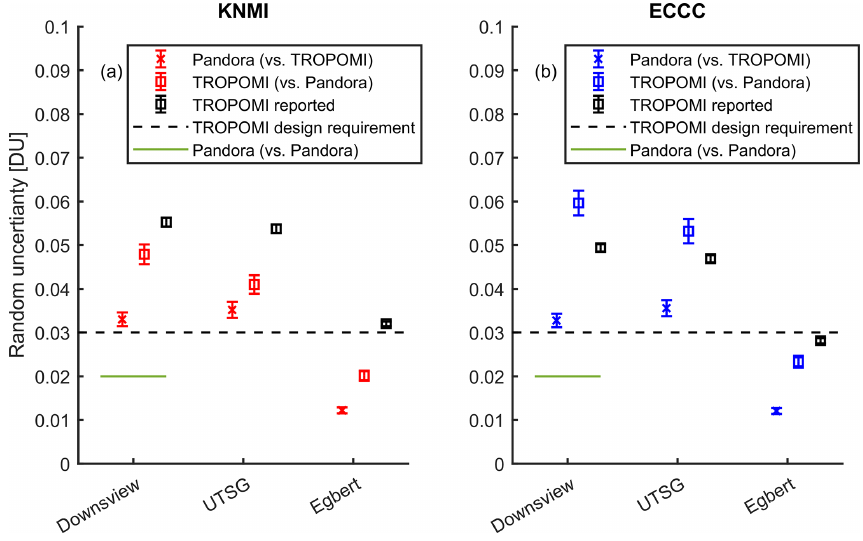
Figure 11. Statistical uncertainty estimations for TROPOMI and Pandora total column NO 2 , using their coincident measurements paired by wind-based methods. (a) TROPOMI KNMI vs. Pandoras at three sites (site names are on the x axis); the estimated statistical random uncertainties are shown in red with estimated errors. Black squares represent the mean of reported uncertainties for TROPOMI KNMI NO 2 data, with error bars representing the uncertainty of the mean. (b) TROPOMI ECCC vs. Pandoras at three sites ( x axis); the estimated statistical random uncertainties are shown in blue with estimated errors. Black squares represent the mean of reported uncertainties for TROPOMI ECCC NO 2 data, with error bars representing the uncertainty of the mean. The black dashed line is the TROPOMI design requirement for precision, while the green line is the Pandora instrument precision estimated independently (statistical estimation using co-located Pandoras at